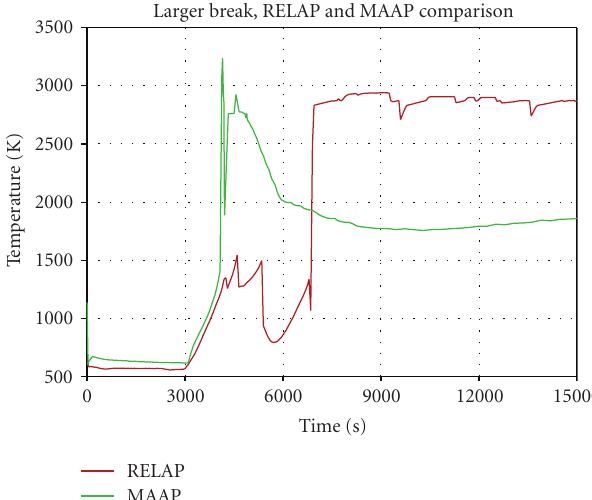
Figure 17: Core maximum temperature, Group 2.